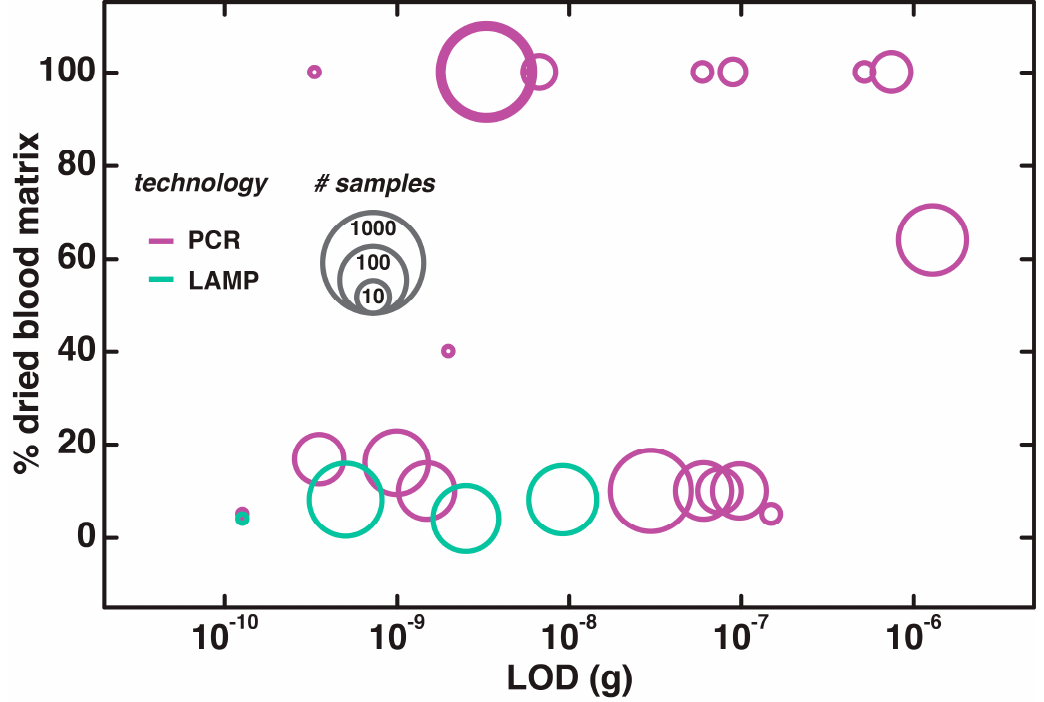
Figure 4. Nucleic acid testing with dried blood spots, with data presented as in Figure 3.